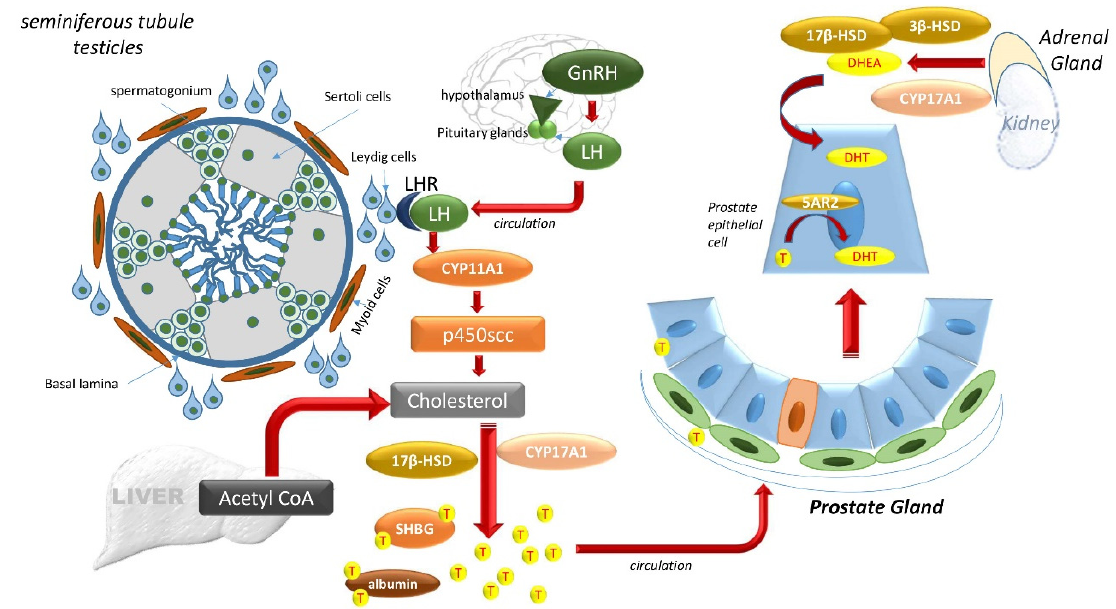
Figure 3. The hypothalamus-pituitary-testes axis and the adrenal gland controls DHT .